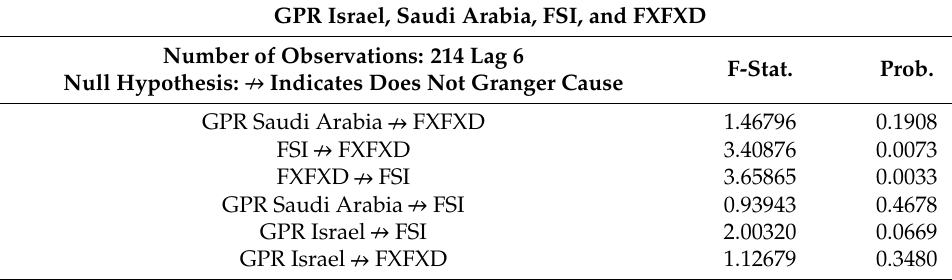
Table 12. Granger causality Tests: ECO, FSI, and FXFXD. Table 13. Granger causality tests: GPR Israel, Saudi Arabia, FSI, and FXFXD. Table 14. Granger causality tests with one GPR.